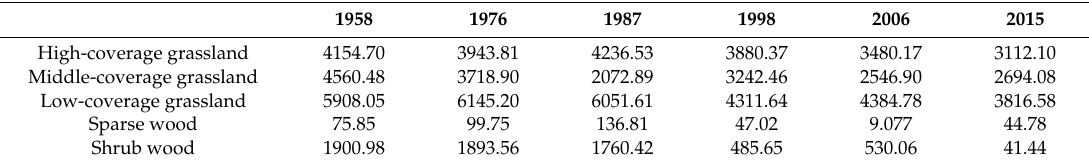
Table 2. Changes in natural forests and grasslands from 1958 to 2015; unit: km 2 . 1958